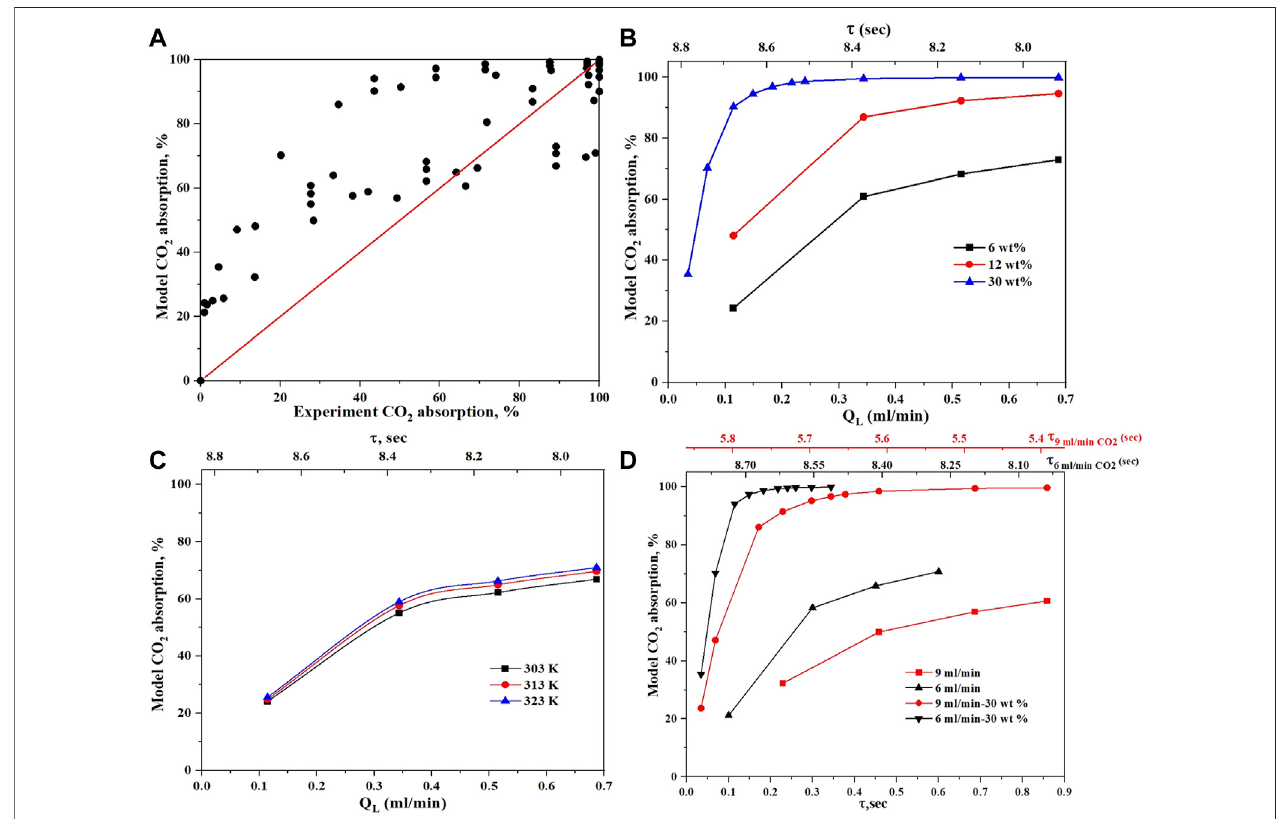
FIGURE 10 | Simulation results as obtained from the microreactor mathematical model. (A) parity plot for all data experiments versus model, (B) effect of MEA concentration (experimental result is in Figure 5A ). (C) effect of temperature on the MEA (experimental result is in Figure 6A ). (D) effect of gas fl ow rate (experimental result is in Figure 7